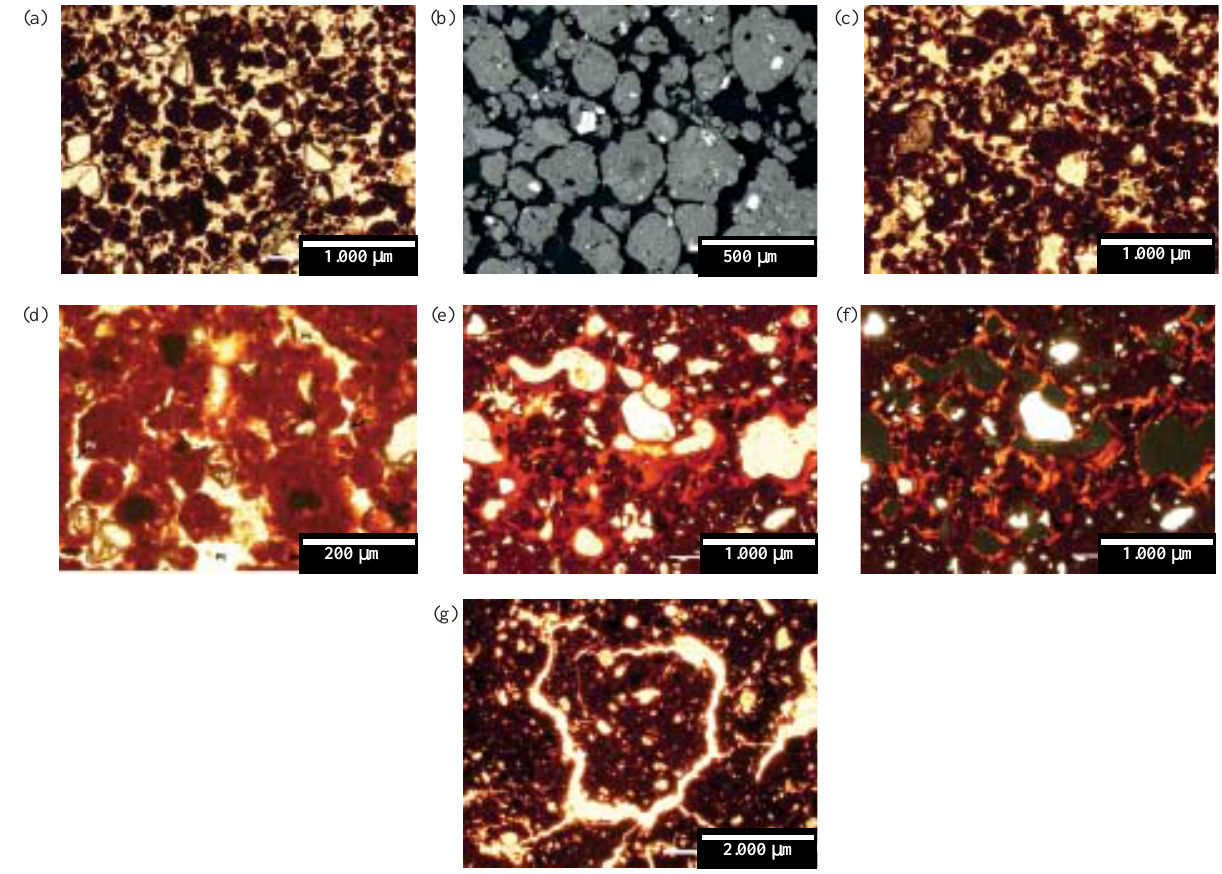
Figura 1. Microfotografias dos processos de adensamento, iluviação e fissuração. (a) Estrutura microgranular com porosidade de empacotamento e trama enáulica; (b) Imagem em elétrons retroespalhados detalhando a estrutura microgranular; (c) Microagregados coalescidos; (d) Detalhe dos microagregados coalescidos e formação de cavidades policôncavas; (e) Revestimentos de argila iluvial (feições pedológicas texturais) preenchendo a porosidade de empacotamento e cavidades policôncavas e cimentando os microagregados (PPL); (f) Mesma imagem em XPL; (g) Blocos subangulares separados por uma porosidade fissural e cavidades policôncavas no interior